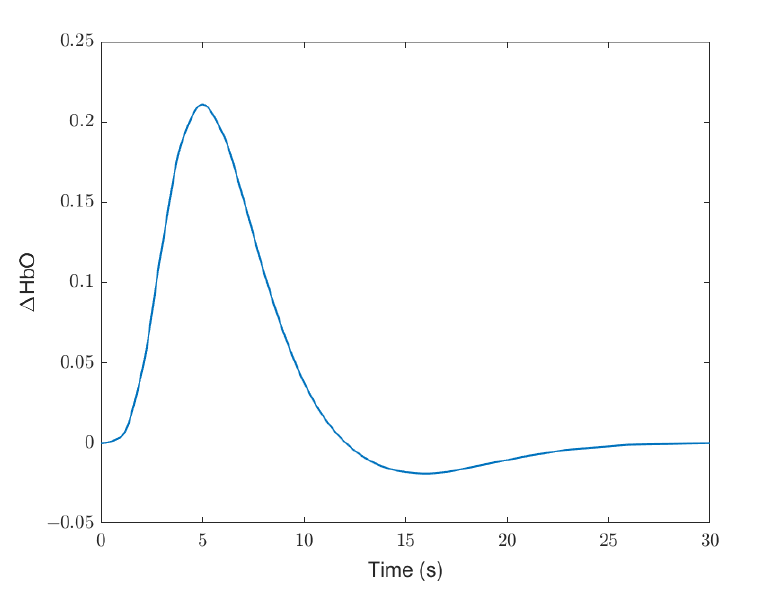
Figure 13. Canonical haemodynamic response function